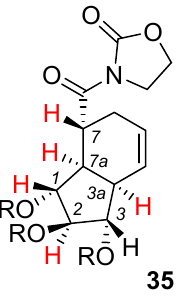
Figure 14. The structure of bicyclic compound 35 and the numbering of the atoms.